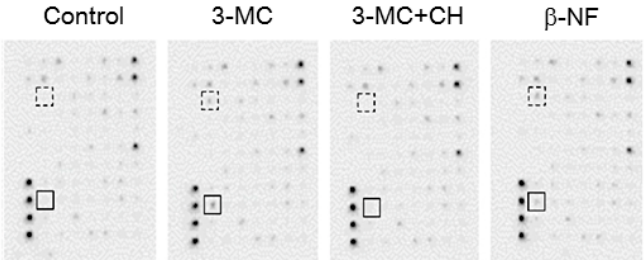
Figure 4. Cytokine profiles derived from hFOB cells treated with AhR agonists. Both IL-6 and IL-1 β immunoreactivities were detected in hFOB cells treated with AhR agonists (10 μ M 3-MC and 10 μ M β -NF). Both IL-6 and IL-1 β were not expressed at detectable levels in hFOB cells co-treated with AhR antagonist and 3-MC as well as in control cells (vehicle control; 0.005% dimethyl sulfoxide). Solid line square, IL-6; dashed line square, IL-1 β ; CH, 10 μ M CH-223191.